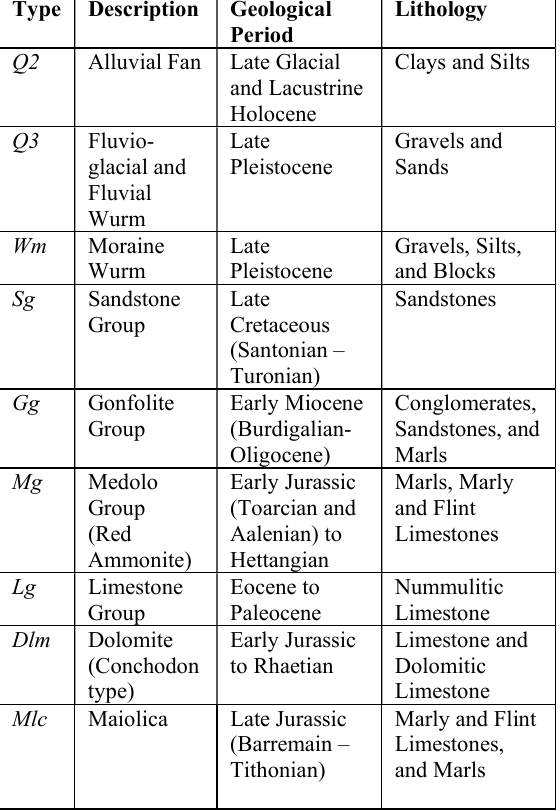
Table 1 . Description of geological map (Regione Lombardia,